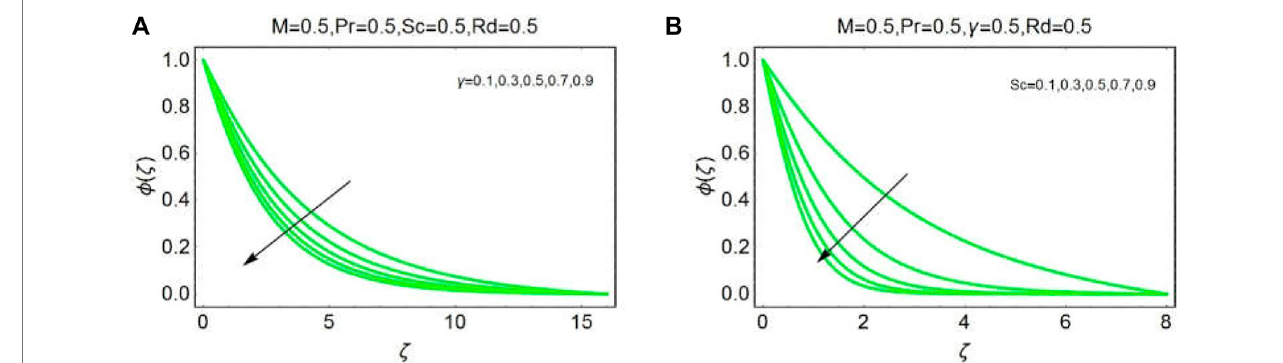
FIGURE 8 | In fl uence of (A) γ and (B) Sc on ϕ ( ζ ) .